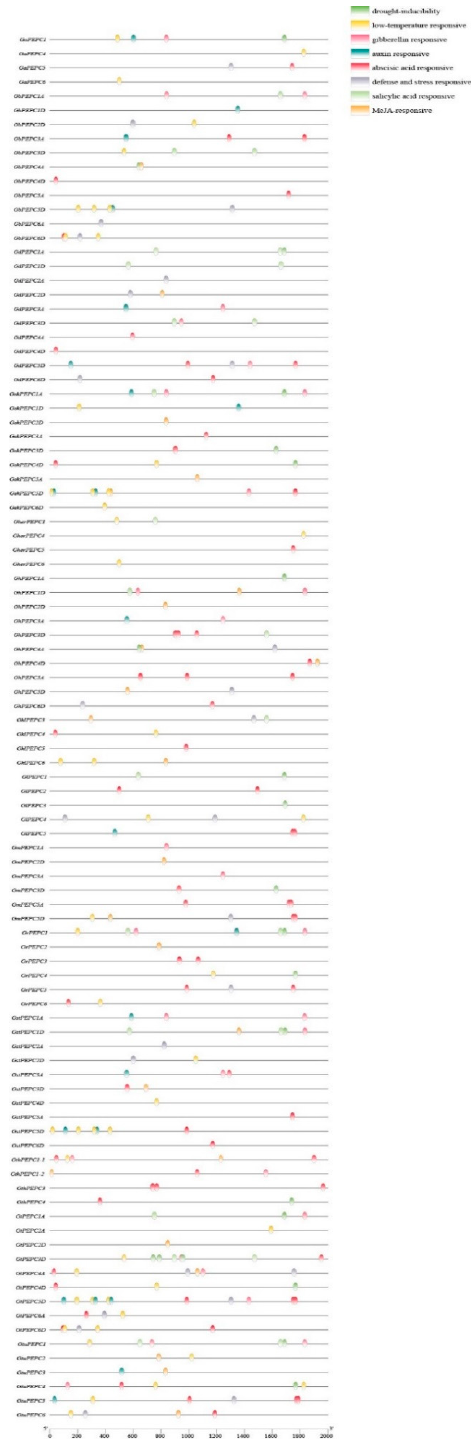
Figure 4. Promoter analyses of PEPC genes. The promoter sequences (2 kb upstream of ATG) of the PEPC genes were analyzed by PlantCARE.